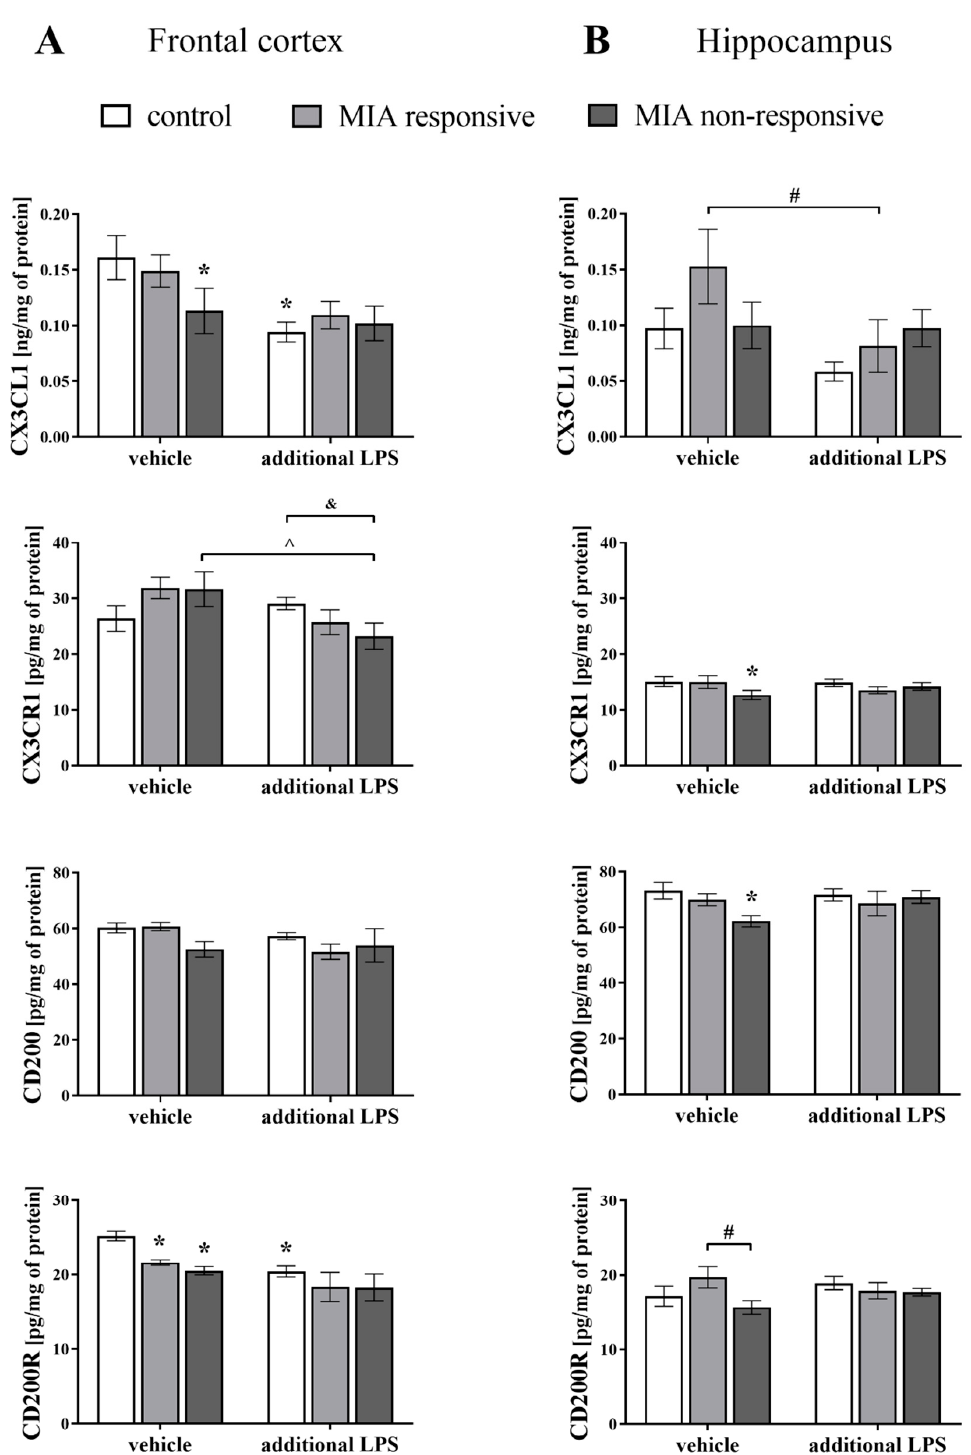
Figure 7. The effect of MIA and the additional acute challenge with LPS on the protein levels of CX3CL1, CX3CR1, CD200 and CD200R in the frontal cortices ( A ) and hippocampi ( B ) of male Sprague-Dawley offspring at PND120. n = 4–10 in each group. The results are presented as the means ± SEM. * p < 0.05 vs. control + vehicle, # p < 0.05 vs. MIA responsive + vehicle, ^ p < 0.05 vs. MIA non- responsive + vehicle, & p < 0.05 vs. control + LPS.